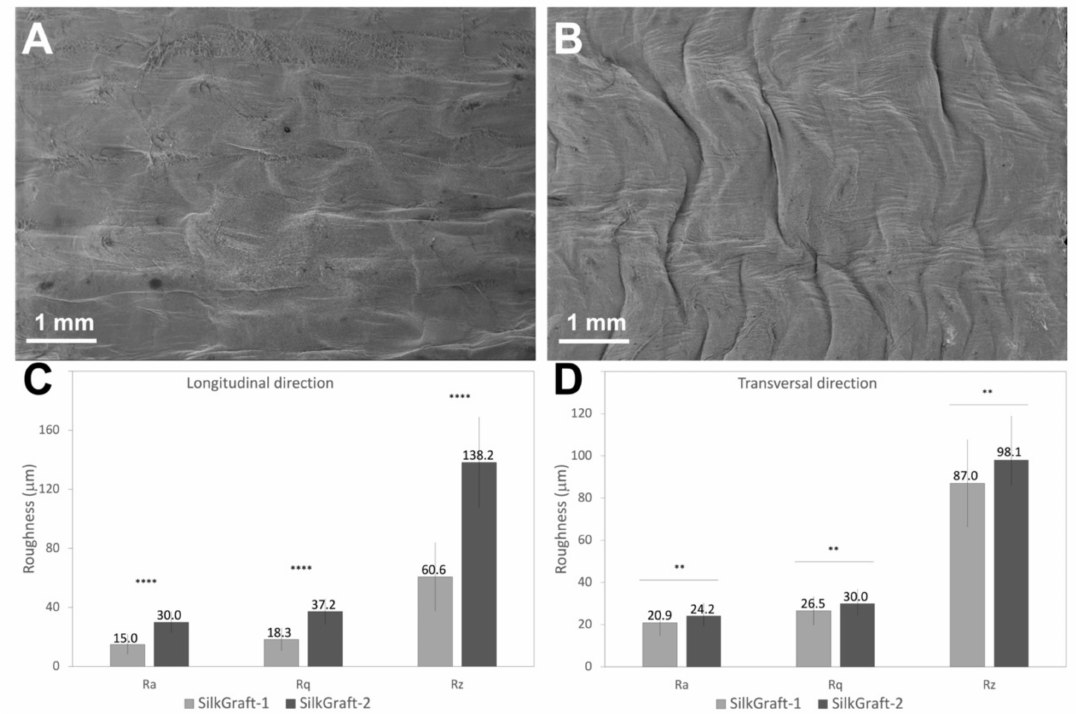
Figure 2. ( A ) Typical SEM surface morphology of the inner ES layer of the SILKGraft-1/1 Plus designs. ( B ) Typical SEM surface morphology of the inner ES layer of the SILKGraft-2/2 Plus designs. ( C , D ) are plots of the average values of R a , R q , and R z measured in the longitudinal and transversal directions, respectively. Statistical significance: p < 0.0001 (****); p < 0.01 (**). The source data used for the graphs are reported in Tables S3 and S4 for the longitudinal and transversal direction, respectively (Supplementary